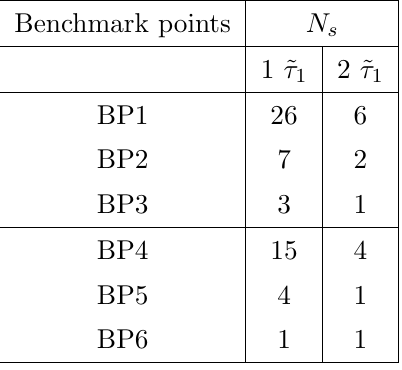
= 3000 fb (cid:0) 1 L